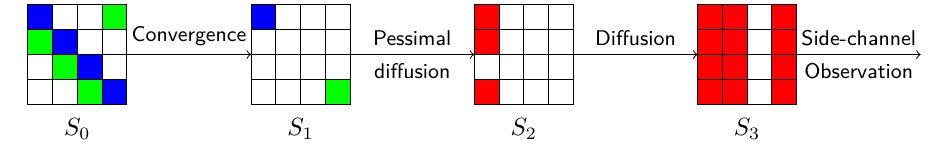
Figure 11: AES differential pattern for 4-round attack. Active bytes are in red, blue or green, where blue bytes in PT converge to a single blue byte in S 1 , similarly for the green